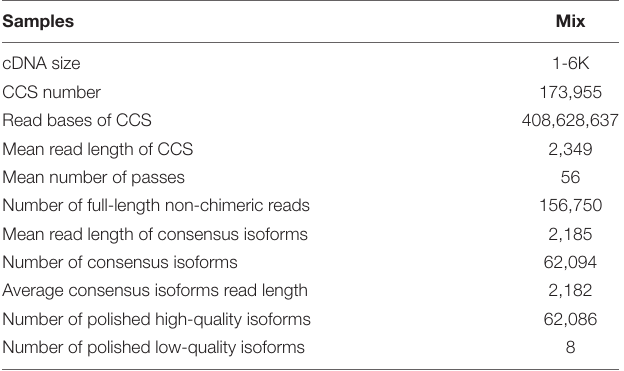
TABLE 1 | Single molecular real time sequencing